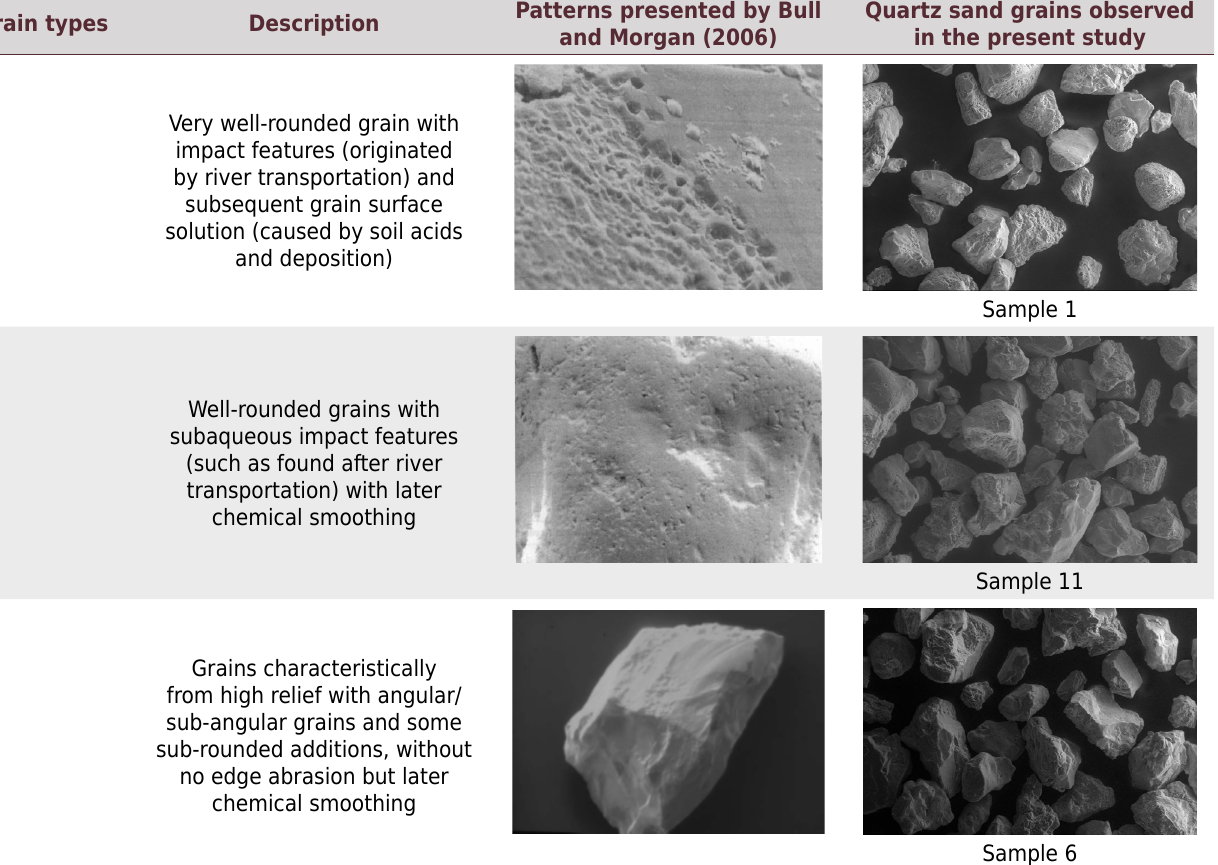
Table 2. Different quartz types according to Bull and Morgan (2006) and their correspondence with the quartz sand grain of the studied samples obtained by SEM-EDS Quartz grain